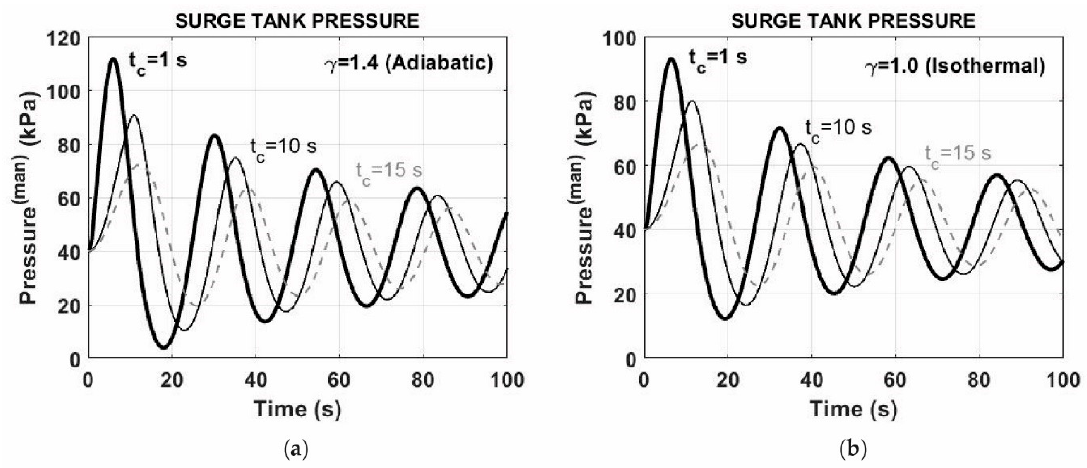
Figure 4. Surge tank pressure raise. ( a ) Adiabatic behavior for t c = 1, t c = 10 and t c = 15 s of closure time of guide vanes; and, ( b ) Isothermal behavior for t c = 1, t c = 10 and t c = 15 s of closure time of guide vanes.